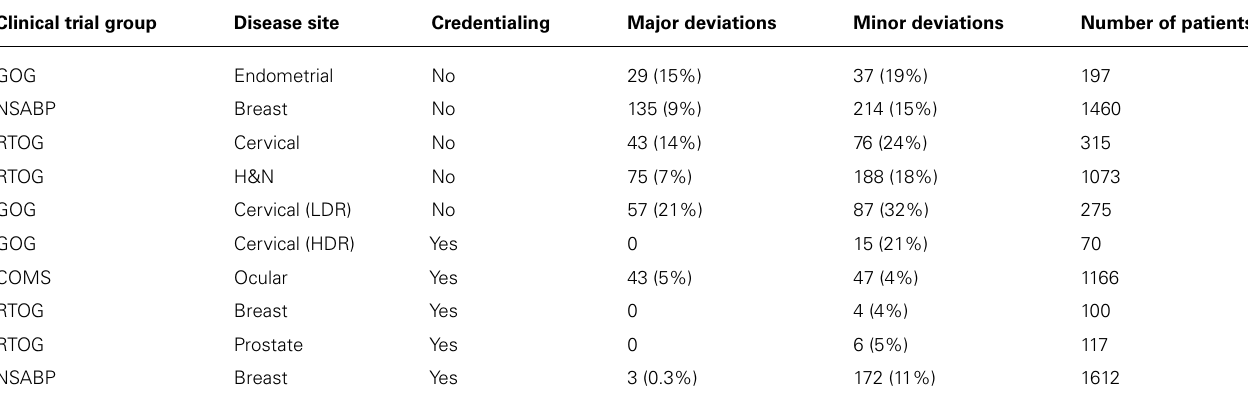
Table 1 | Comparison of deviation rates for clinical trial studies with and without radiotherapy